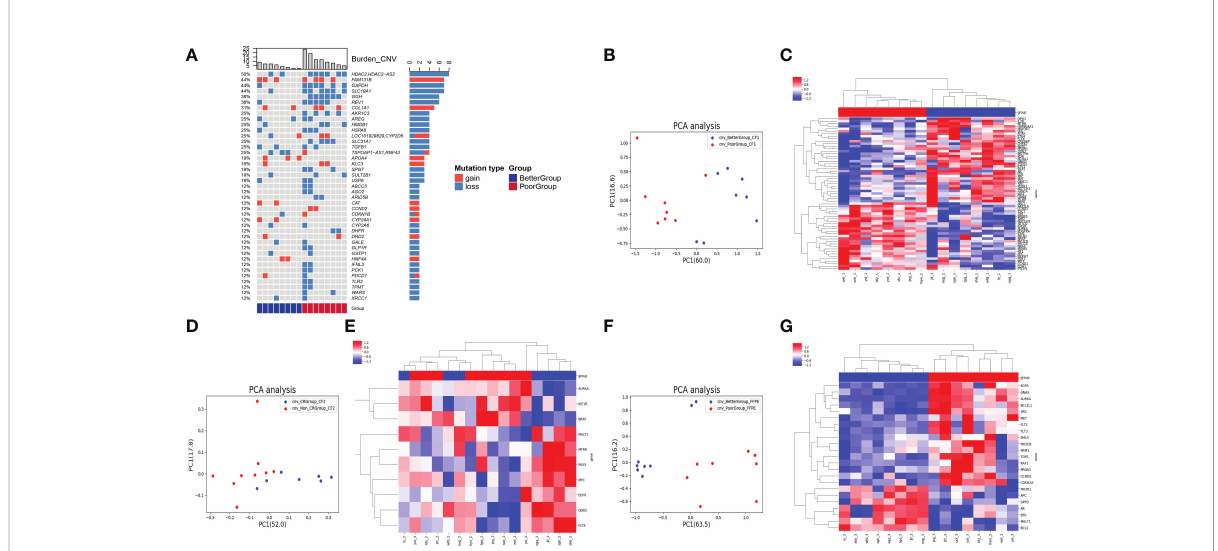
FIGURE 2 Analysis of CNV in 3 types of samples on therapeutic response. (A) The heatmap showed genes with CNV in descending order of occurrence frequency. The columns represent the RC patients and the rows represent the genes. The colors on the right represent the ef fi cacy groups and CNV type. (B) The PCA dimensionality reduction and cluster analysis for CNV level in baseline blood. (C) The heatmap demonstrated the CNV level of the principal component genes in baseline blood could signi fi cantly distinguish the two groups of patients. (D) The PCA dimensionality reduction and cluster analysis for CNV level in the blood after nCT. (E) The heatmap demonstrated the CNV level of the principal component genes in the blood after nCT. (F) The PCA dimensionality reduction and cluster analysis for CNV level in cancer tissues obtained from surgery. (G) The heatmap demonstrated the CNV level of the principal component genes in cancer tissues could signi fi cantly distinguish the two groups of